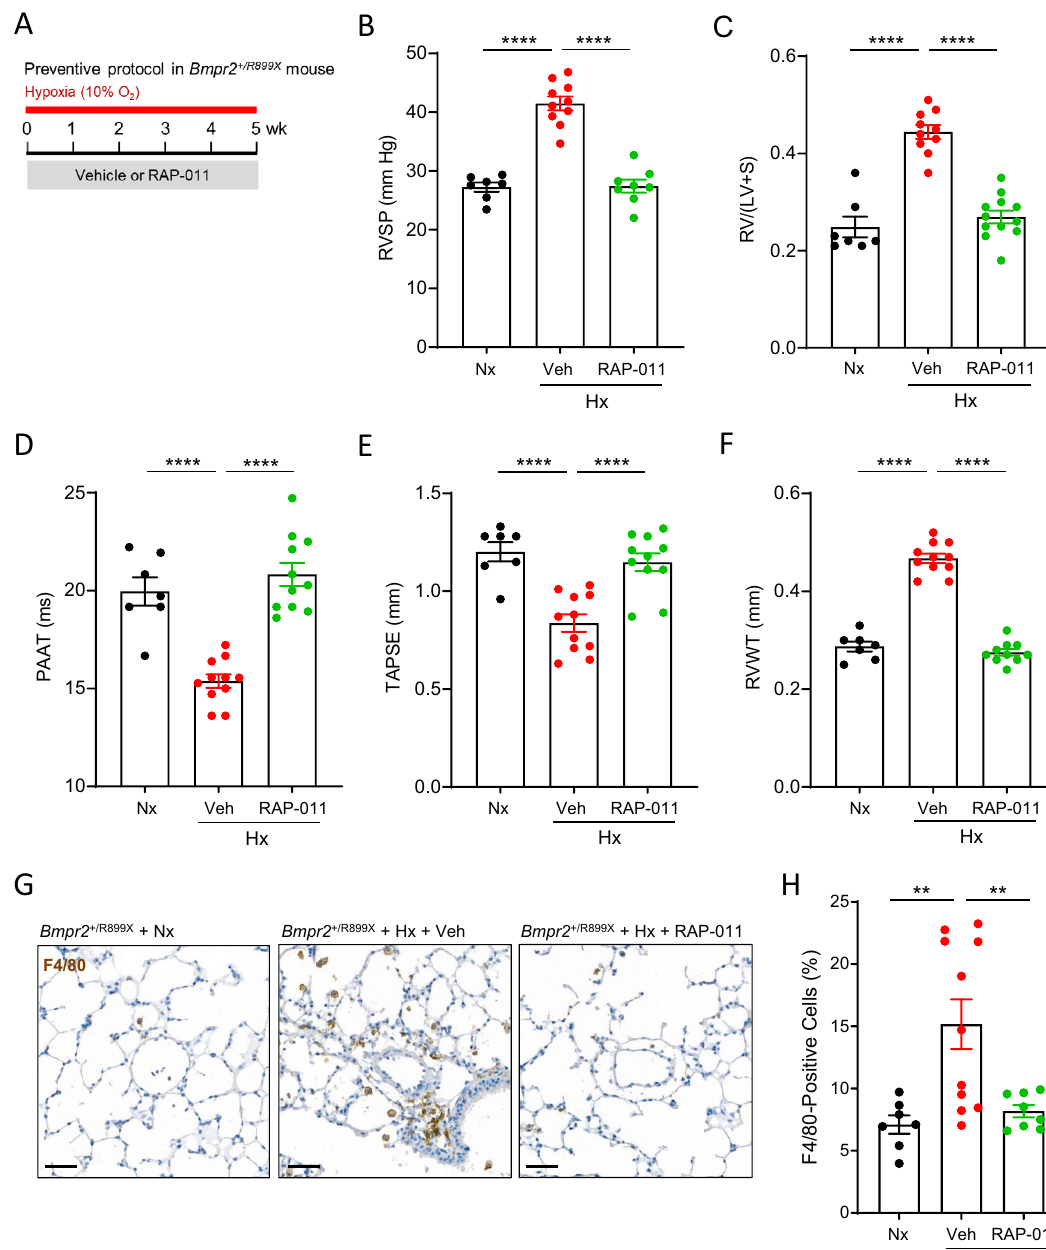
Figure 5. ActRIIA-Fc reduces pulmonary macrophage infiltration and prevents PH in a mouse model of Bmpr2 haploinsufficiency. ( A ) Experimental approach used to evaluate cardiopulmonary effects of RAP-011 in mice with Bmpr2 haploinsufficiency. Bmpr2 + /R899X mice were housed under normoxic conditions (Nx) as controls or exposed to normobaric hypoxia (10% O 2 ) and treated twice-weekly with either RAP-011 (10 mg/ kg, s.c.) or vehicle (PBS) for 5 weeks. ( B ) RVSP, ( C ) Fulton index, ( D ) PAAT, ( E ) TAPSE, and ( F ) RVWT. ( G ) Representative images of lung sections immunostained for macrophage marker F4/80. ( H ) Quantification of F4/80-positive cells in lung based on assessment of 30 high-magnification fields per mouse. Scale bar, 50 µm. Data are means ± SEM (n = 7–10 per group). Analysis by one-way ANOVA and Tukey post hoc test. * P < 0.05, ** P < 0.01, *** P < 0.001, **** P <